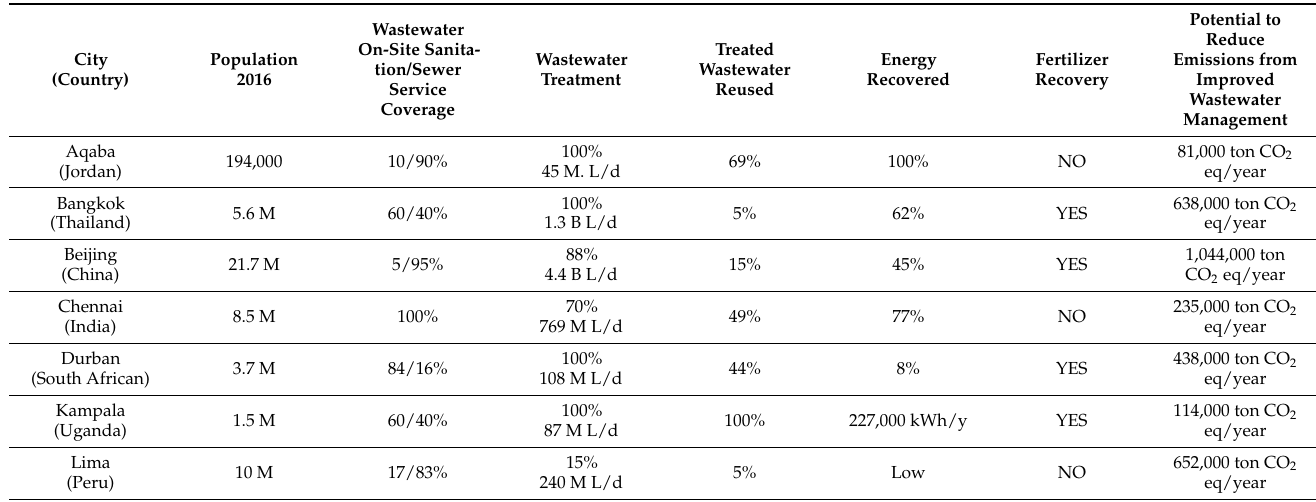
Table 1. Cities with wastewater resource recovery facilities. Adapted from [16].